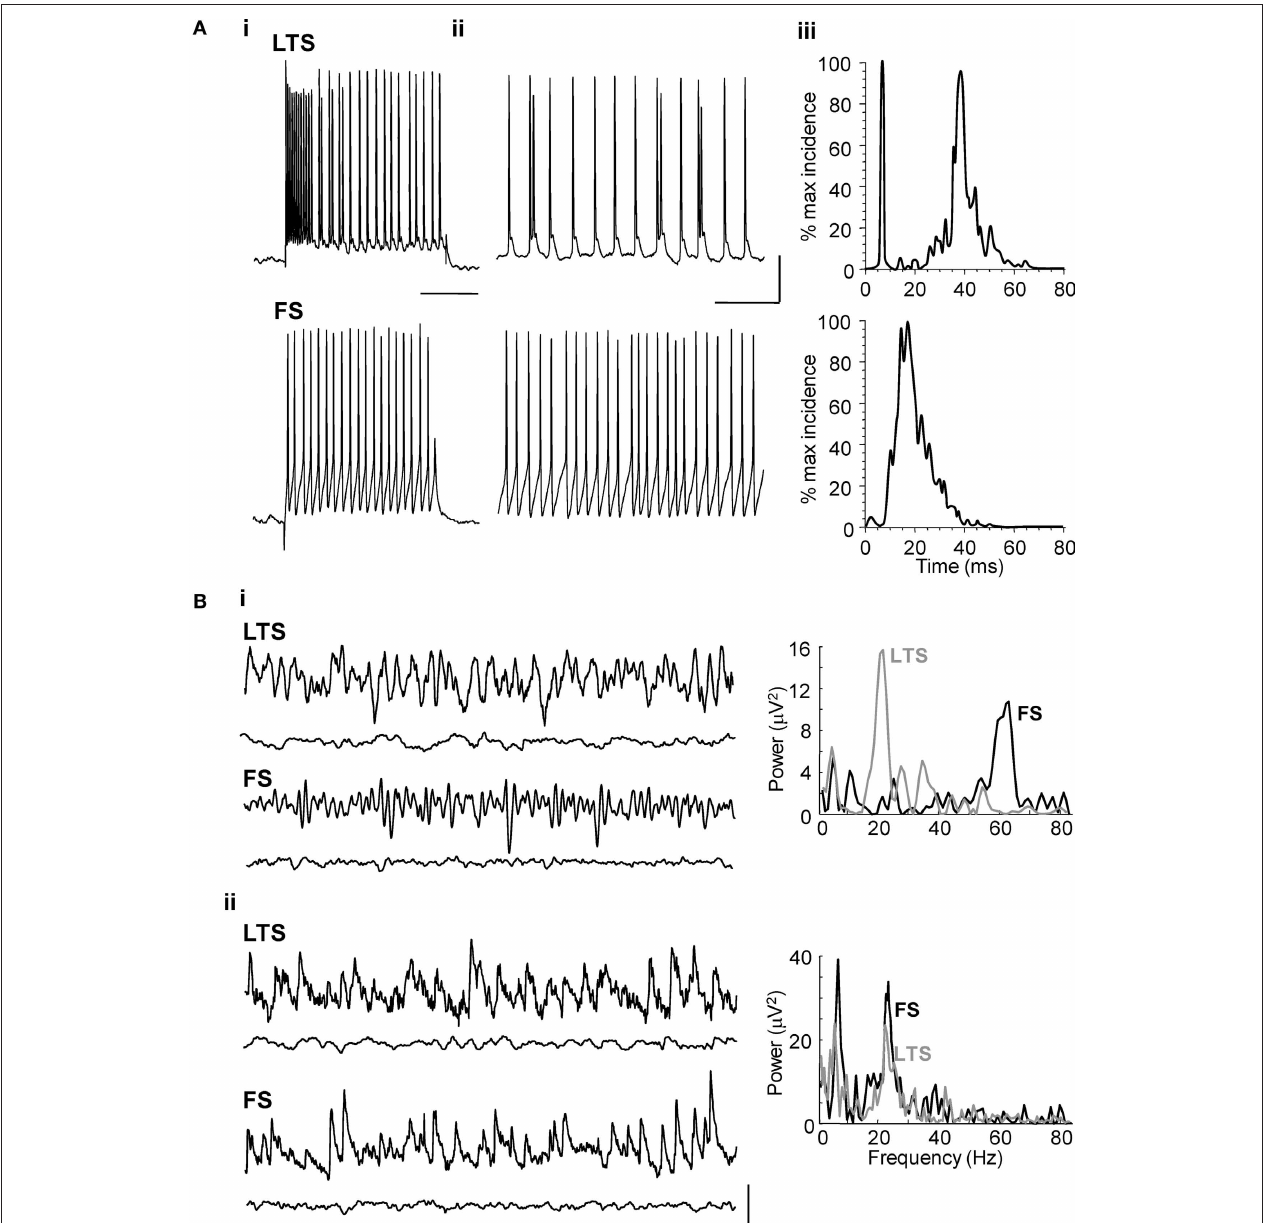
FiGurE  | Layer V LTS interneuron – but not FS interneuron – outputs are at beta frequency during cholinergically driven Au rhythms. (A) Intracellular recordings from layer IV/V interneurons in the primary auditory cortex. (Ai) Current steps of 0.2 nA characterised the layer V cells as LTS or FS interneurons in experiment. (Aii) The firing rate of an LTS cell and an FS cell at resting membrane potential (RMP = − 62 and − 56 mV, respectively) during carbachol- induced oscillations. (Aiii) Corresponding spike-frequency histograms from 60 s epochs of activity in each cell type. Note only LTS cells generate outputs at beta frequency. Scale bar for current step: 10 mV, for on-going spike generation 15 mV, 100 ms. (B) Excitatory and inhibitory synaptic inputs to LTS and FS